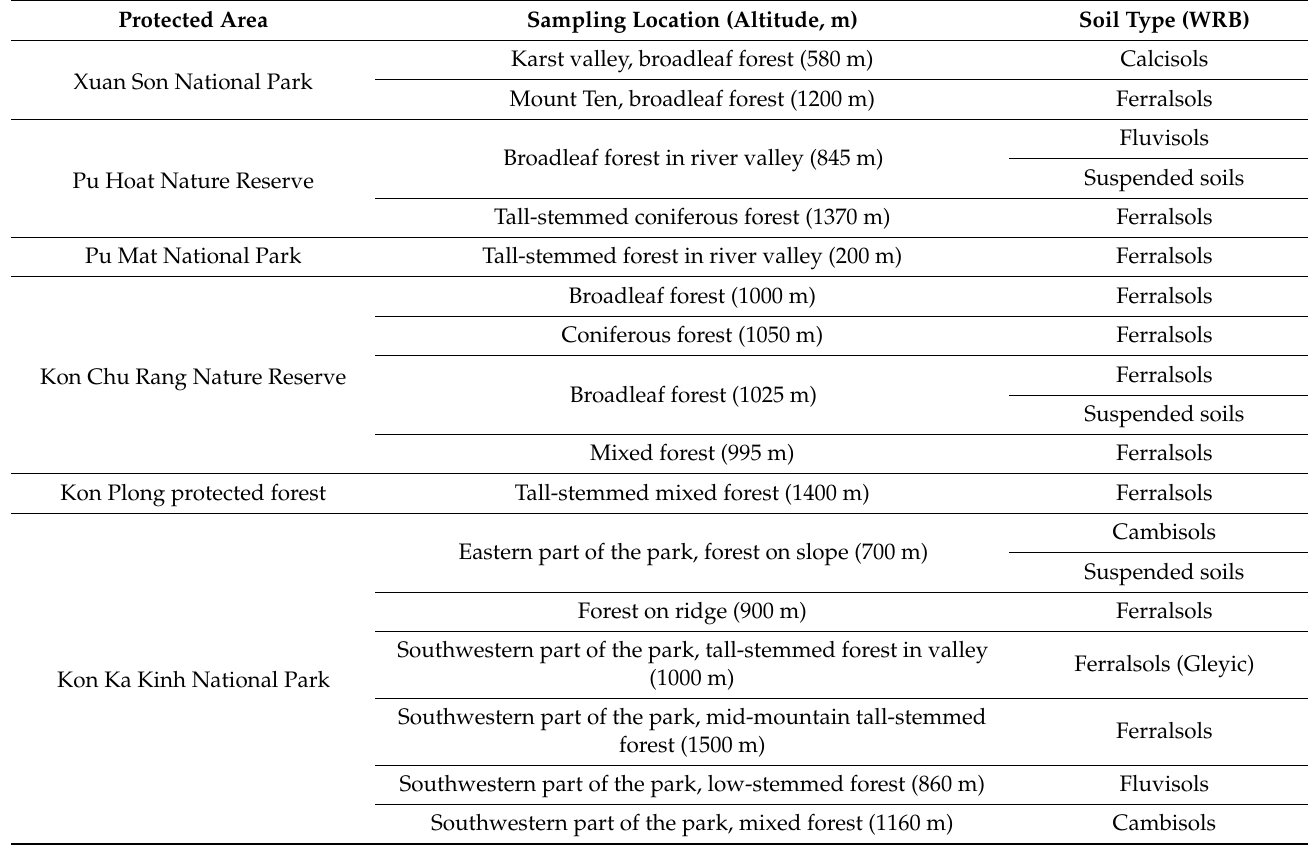
Table 1. Ecotopes (sorted from north to south) and soil types according to the World Reference Base for Soil Resources (WRB) in sampling sites.